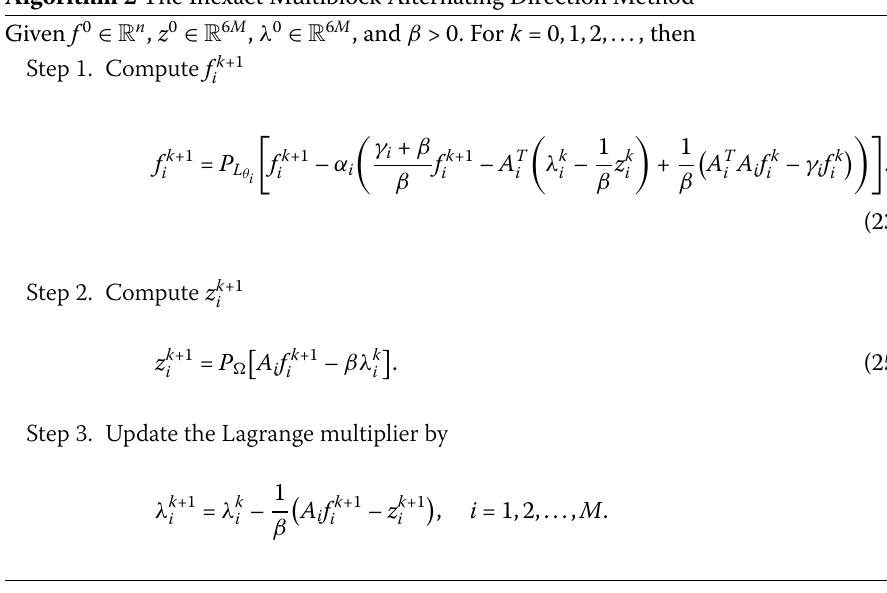
Algorithm 2 The Inexact Multiblock Alternating Direction